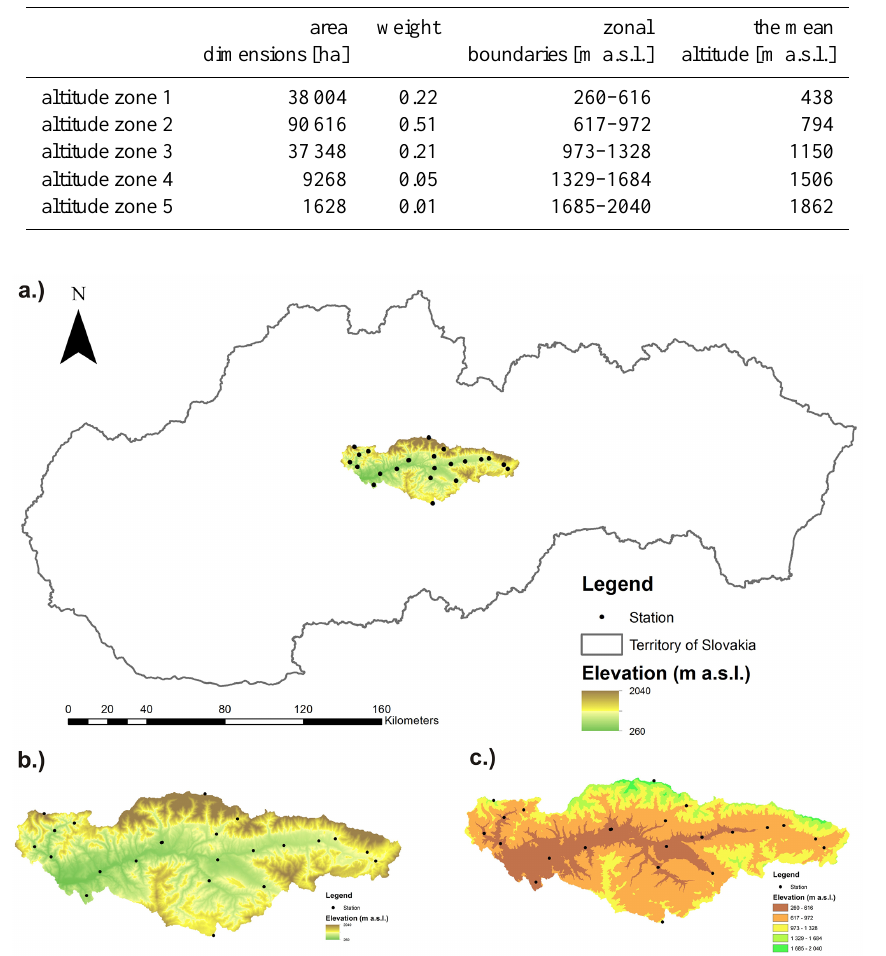
Figure 1. The upper Hron River basin indicating (a) the catchment location in the territory of Slovakia, (b) the elevations of the catchment and precipitation stations, (c) the altitude zones of the